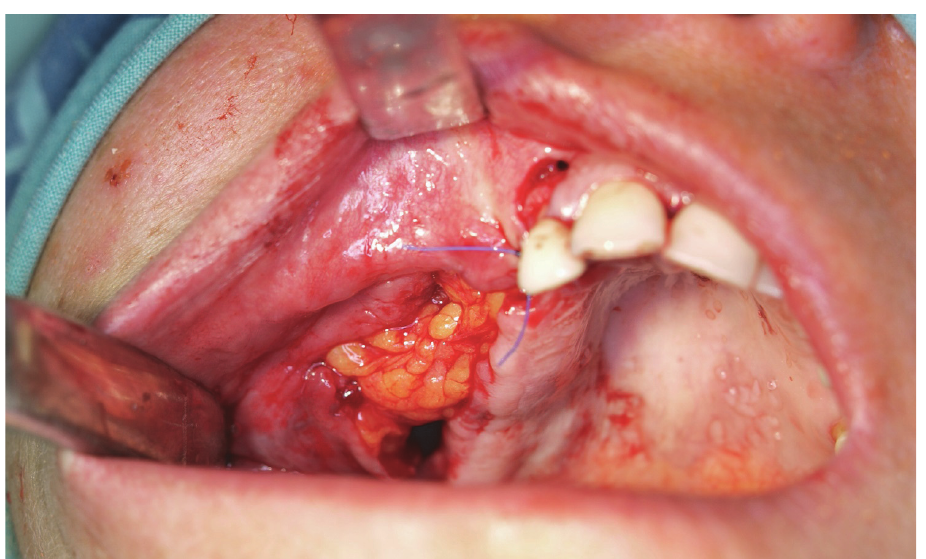
Fig. 3. Two-layers wound closure with buccal fat pad flap to cover oroantral communication in the patient from Fig. 1.